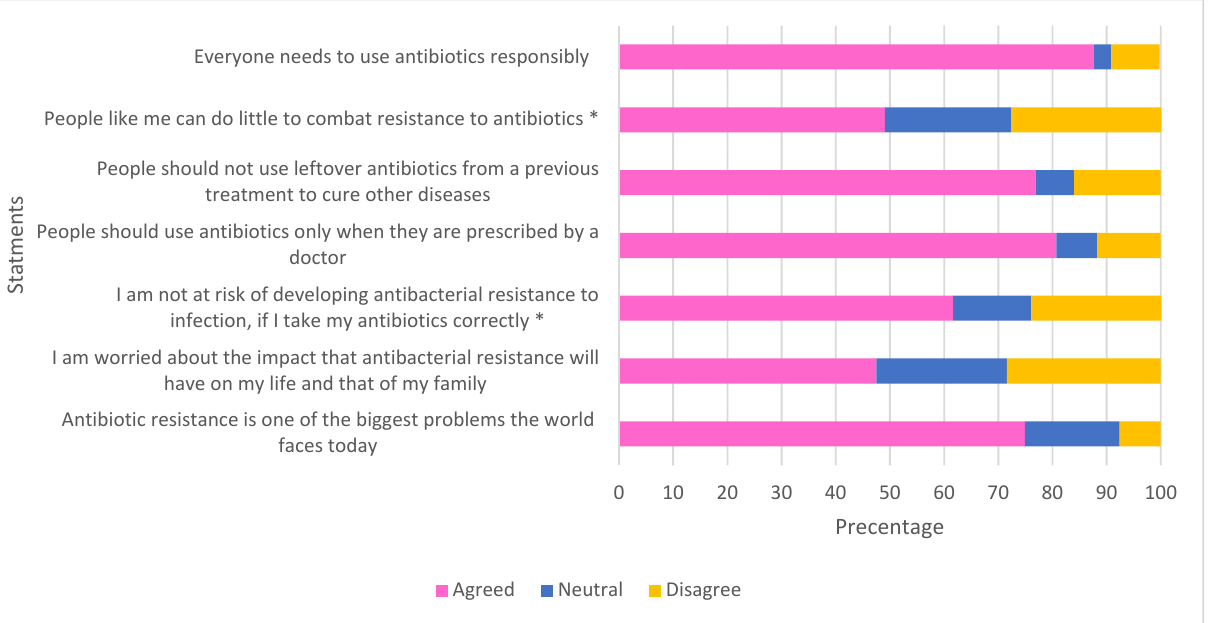
Figure 5. Urban respondents’ perception of AMR. Answers of “agreed” indicate good understanding and attitudes towards AMR, apart from for negatively worded statements (highlighted by *), where “disagree” indicates good understanding and attitudes towards AMR.